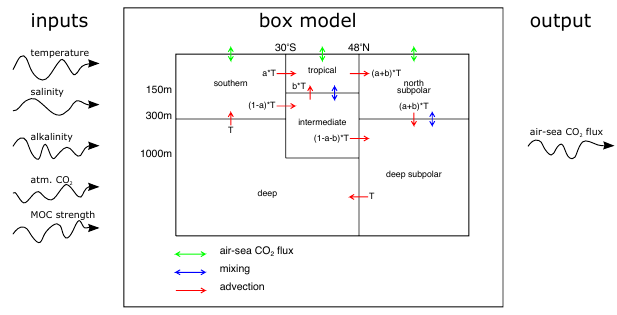
Figure 3. Schematic description of the box